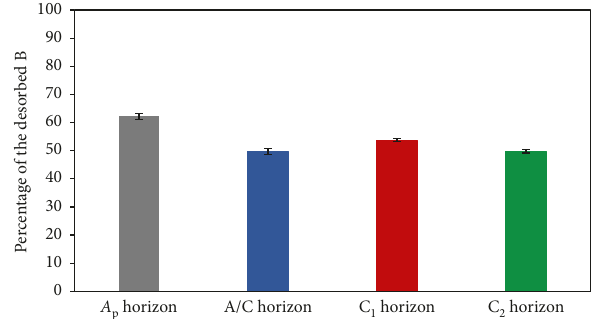
Figure 4: Amounts of desorbed B expressed as percentage of the adsorbed